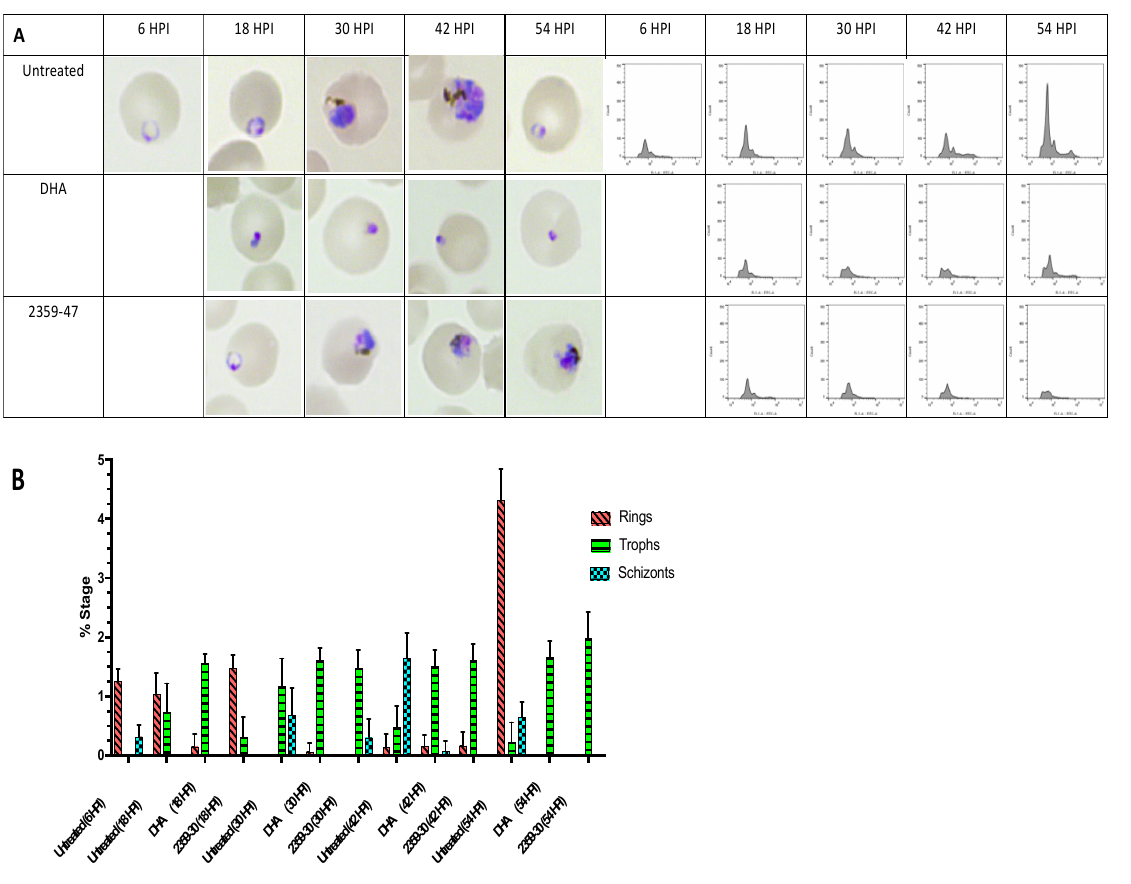
Figure 5. Stage-specific inhibition of Plasmodium growth by TPI 2359-47. Tightly synchronized parasites were treated at 6-h post-invasion of merozoites with 5 × EC 50 concentration of the chemotype. ( A ) Microscopic evaluation of Giemsa-stained thin smears in the left. Histogram plot of YOYO-1 labeled cells following treatment of the compound were shown in the right. ( B ) Distribution of developmental stages at different time intervals following treatment of the compound at 6 h postinvasion. Three replicates of 1000 parasitized erythrocytes were counted to determine stage-specific distribution. DHA, dihydroartemisinin.